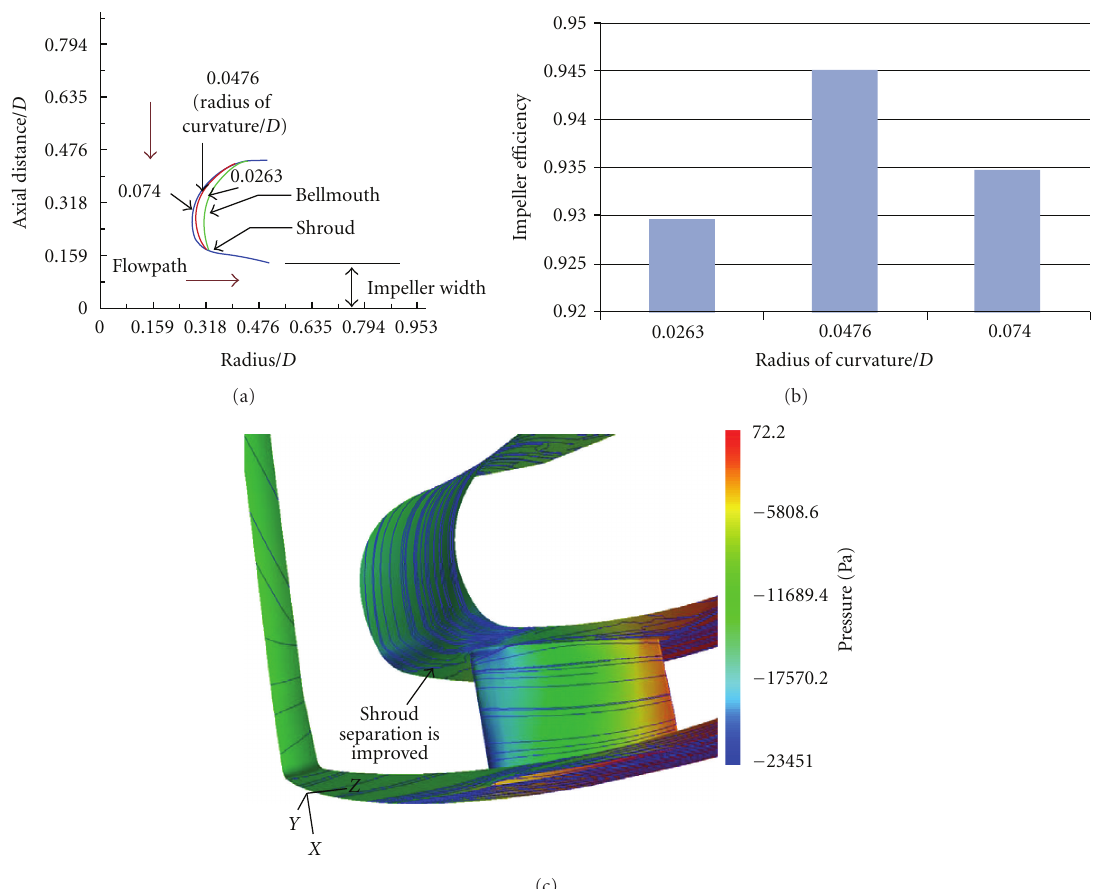
Figure 9: Based on the B#2 impeller (a) bellmouth/shroud profiles investigated; (b) impeller performances; (c) improved separation for the 0.0476